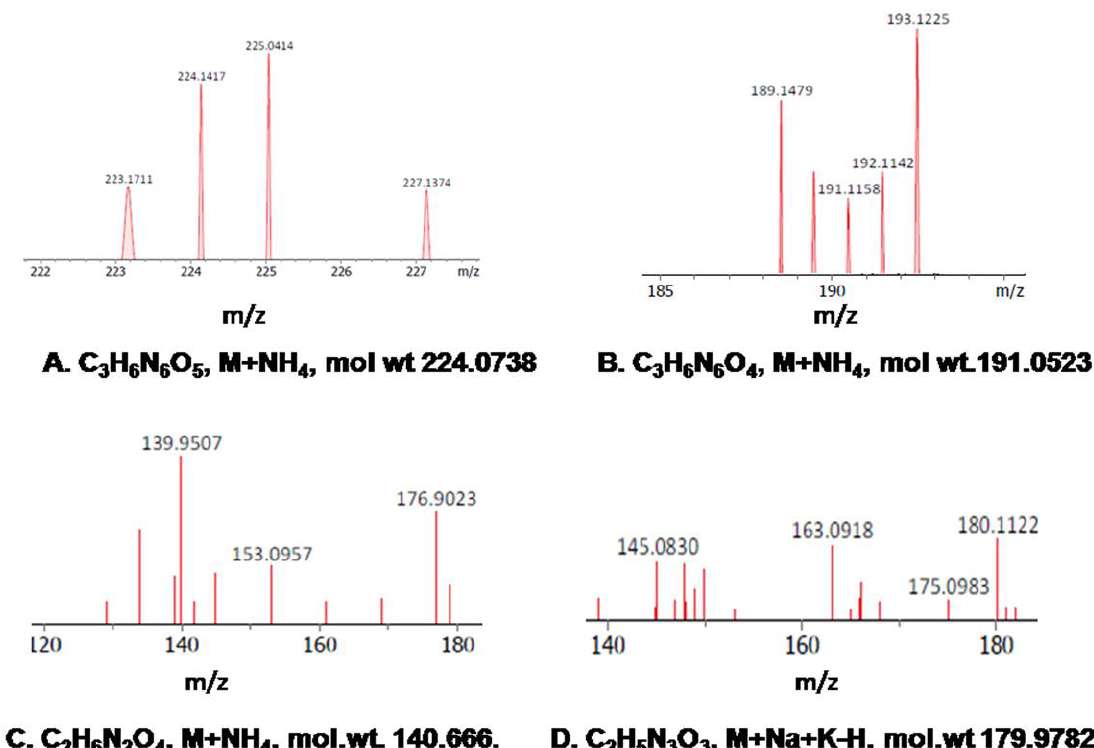
Figure 6. Mass Spectra of metabolites formed during RDX degradation. ( A ) Hexahydro-1-nitroso-3,5-dinitro-1,3,5-triazine (MNX, C 3 H 6 N 6 O 5 , M+NH 4 , mol. wt. 224.07), ( B ) Hexahydro-1,3-dinitroso-5-nitro-1,3,5-triazine (DNX, C 3 H 6 N 6 O 4 , M+NH 4, mol. wt. 191.05), ( C ) Bis(hydroxymethyl)nitramine (C 2 H 6 N 2 O 4 , M+NH 4 , mol. wt. 140.66) and ( D ) 4-Nitro-2,4-diazabutanal (C 2 H 5 N 3 O 3 , M+Na+K-H, mol. wt. 179.97).